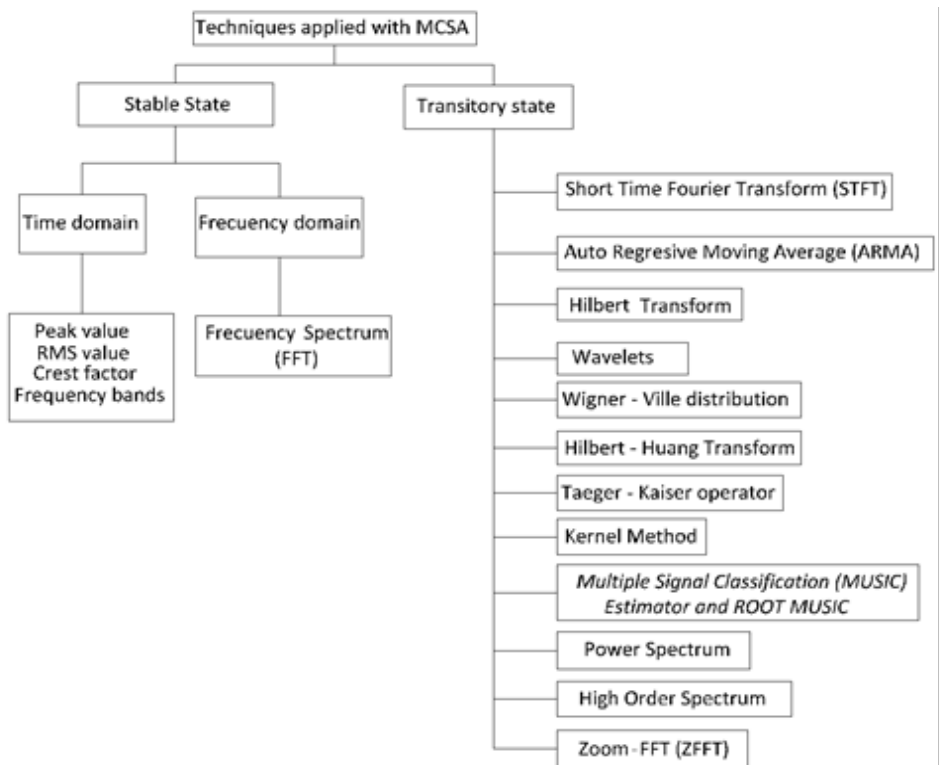
Figure 5. Methods of treatment and analysis of the signals, as shown in